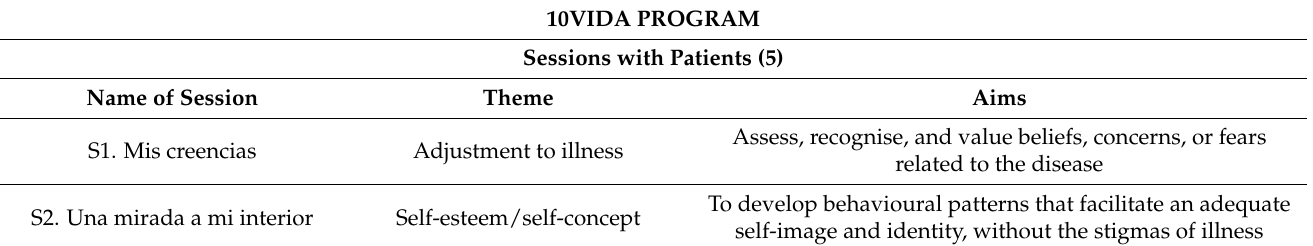
Figure 1. Presentation of the 10Vida programme and its areas.